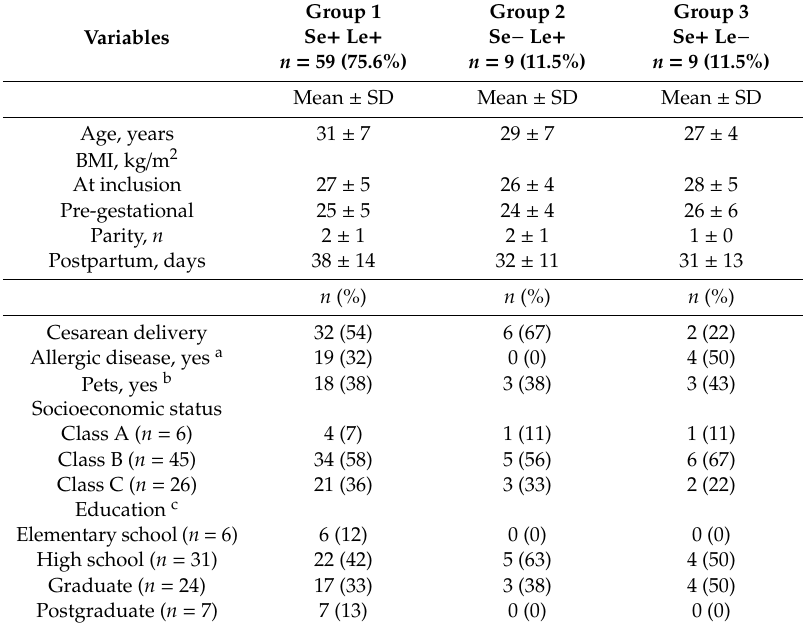
Table 2. Descriptive characteristics of the mothers according to Secretor and Lewis phenotypes.